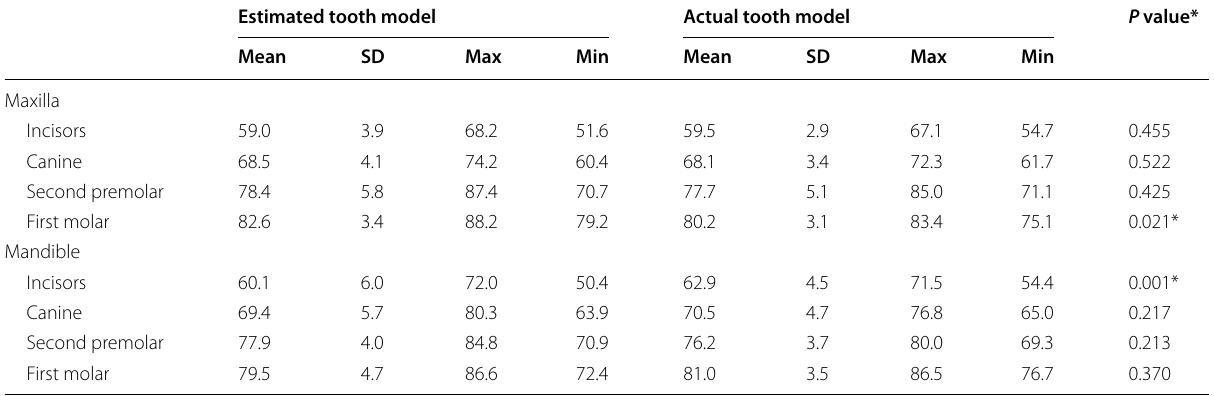
SD, Standard deviation